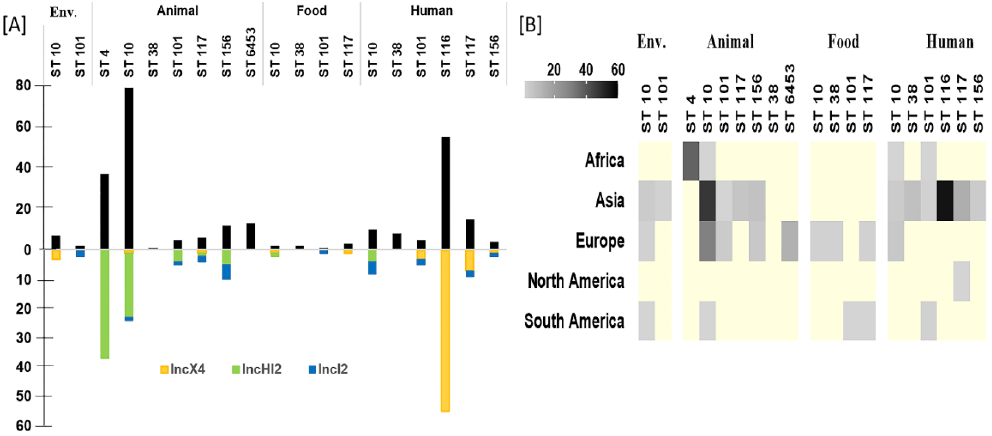
Figure 7. Role of P. E. coli STs in mcr-1 gene dissemination. Particular P. E. coli STs that harbored mcr-1 gene frequency ( A ). The global distribution of P. E. coli harboring mcr-1 gene ( B ). Yellow cells in ( B ) refer to blank, Env. refers to environmental isolates. The scales refer to number of